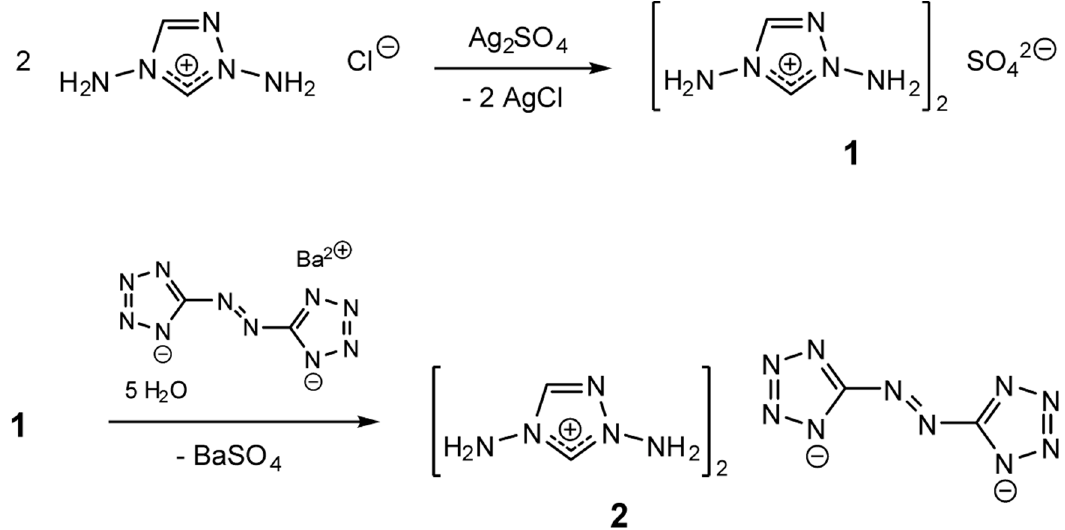
Figure 1. Syntheses of 1,4-diamino-1,2,4-triazolium sulfate ( 1 ) and 5,5 ′ -azotetrazolate ( 2 ). Table 1. Crystal data and structure refinement for 1 and 2 .